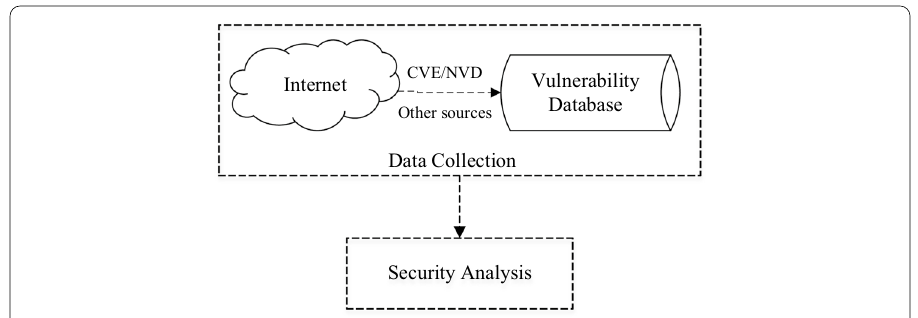
Fig. 6 The process of vulnerability